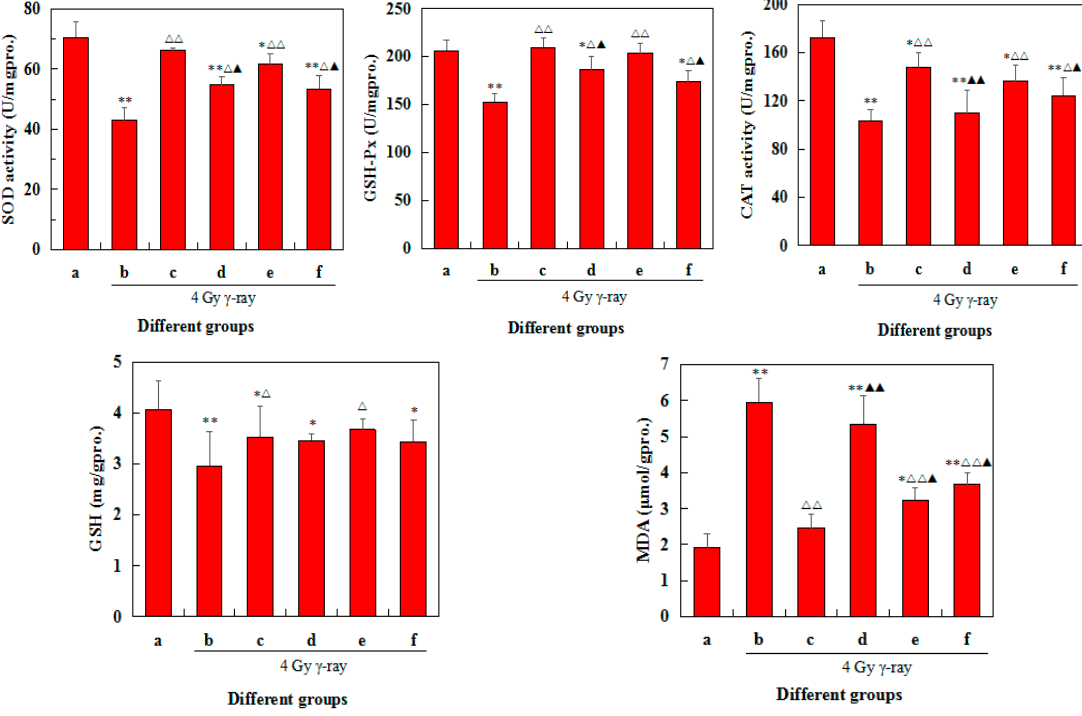
Figure 7. Effects of different doses 5 ′ -AMP pretreatment on the SOD, GSH-Px, CAT, GSH, and MDA levels of spleen tissues (mean ± SD, n = 6). (a) Group I: Normal group; (b) Group II: Model group; (c) Group III: Positive control (berberine hydrochloride); (d) Group IV: Radiation + 5 ′ -AMP (0.08 g/kgBW/day); (e) Group V: Radiation + 5 ′ -AMP (0.16 g/kgBW/day); and (f) Group VI: Radiation + 5 ′ -AMP (0.64 g/kgBW/day). * p < 0.05 and ** p < 0.01 compared with the normal group; Δ p < 0.05 and ΔΔ p < 0.01 compared with the model group. ▲ p < 0.05 and ▲▲ p < 0.01 compared with the positive control group.